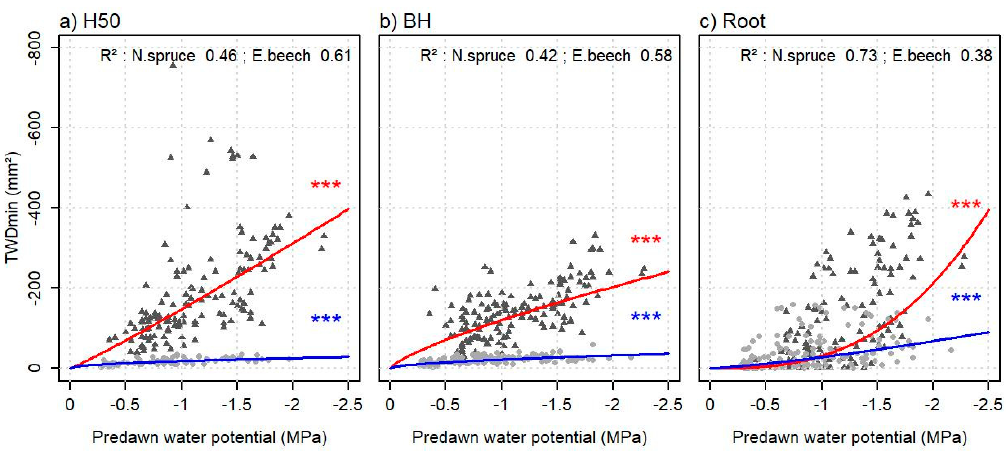
Figure 4. Relationship between TWDmin and predawn water potential (LWPpre) for spruce (red, black triangles) and beech (blue, light grey circles) trees for 50% tree height ( a ), breast height ( b ), and roots ( c ) ( R ² and significance levels based on models from Table 2; *** p < 0.001). Table 2. Parameter estimates and statistics for the logarithmized relationship of the tree water deficit minimum (TWDmin) and the predawn water potential (LWPpre) at three different tree heights (50% tree height (H50), breast height (BH), and roots). All measurements of the TWDmin referred to the stem/root basal area (mm²). The dependent variables are in the columns. Rows show the output of the model with the fixed variables ( N : number of LWPpre and TWDmin measurements). Significance level: *** p < 0.001.